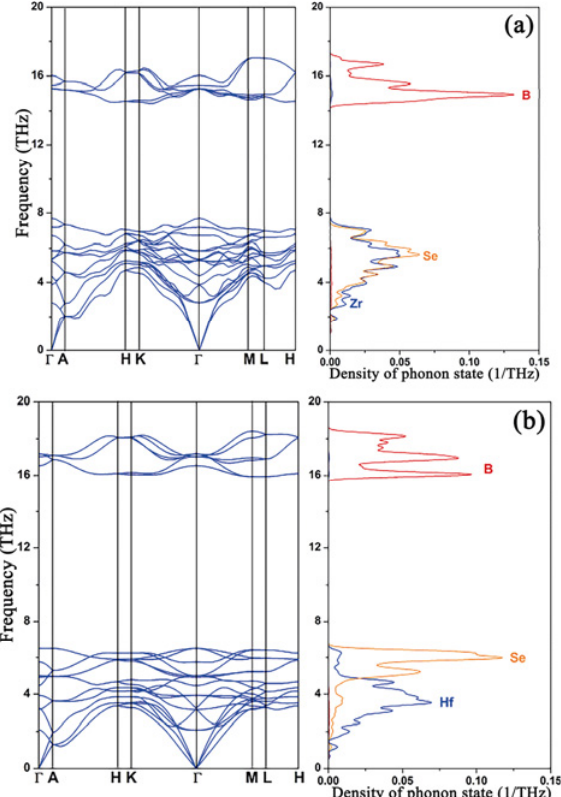
Fig. 3 Phonon dispersions and density of phonon states of (a) Zr 2 SeB and (b) Hf 2